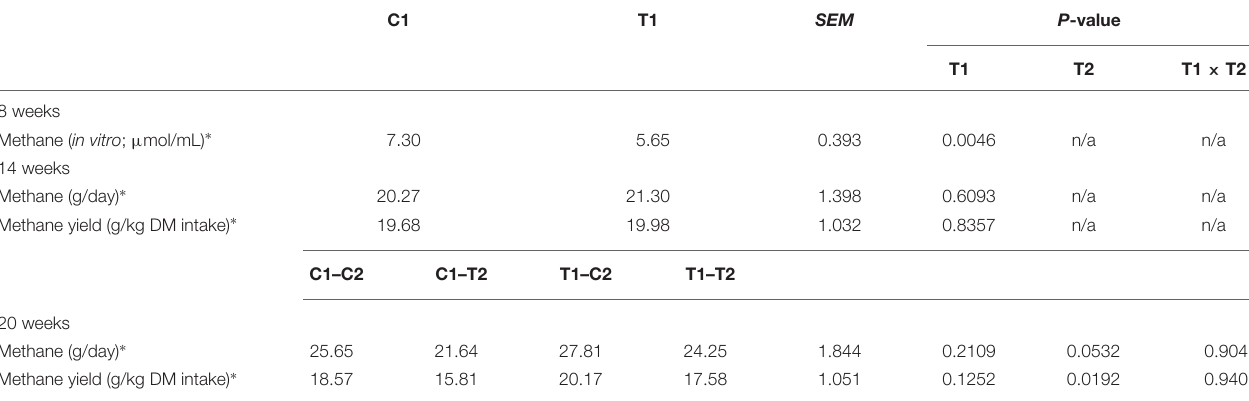
TABLE 1 | Values of methane production potential (8 weeks), methane emissions and methane yields measured in respiration chambers (14 weeks) of control lambs (C1) and lambs treated with a linseed-garlic combination (T1) from birth up to 10 weeks of age. C1 T1